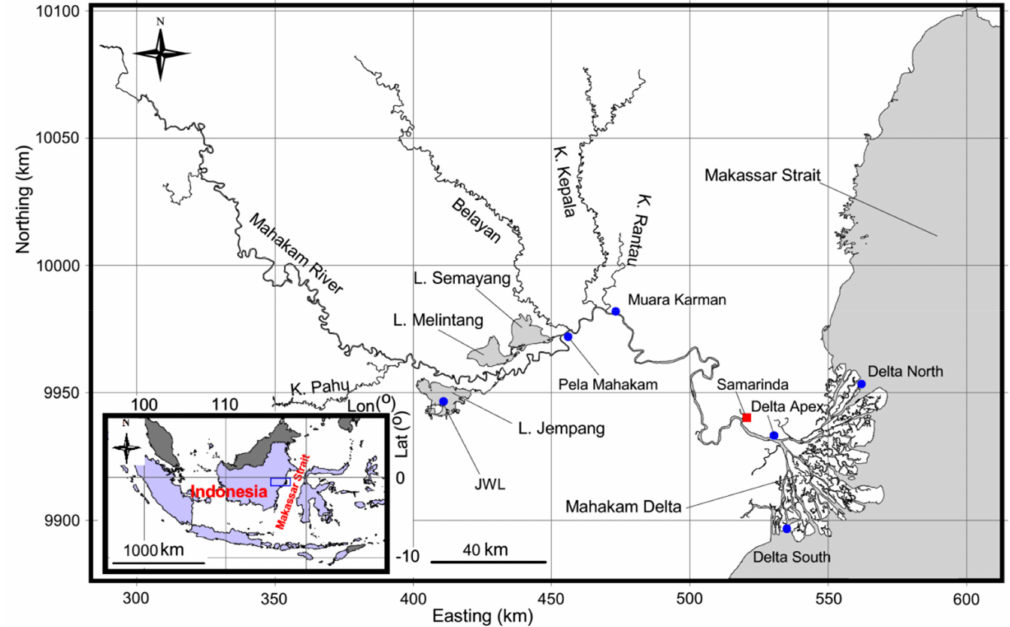
Figure 1. Map of the Mahakam river system and delta channel network, Borneo Island,